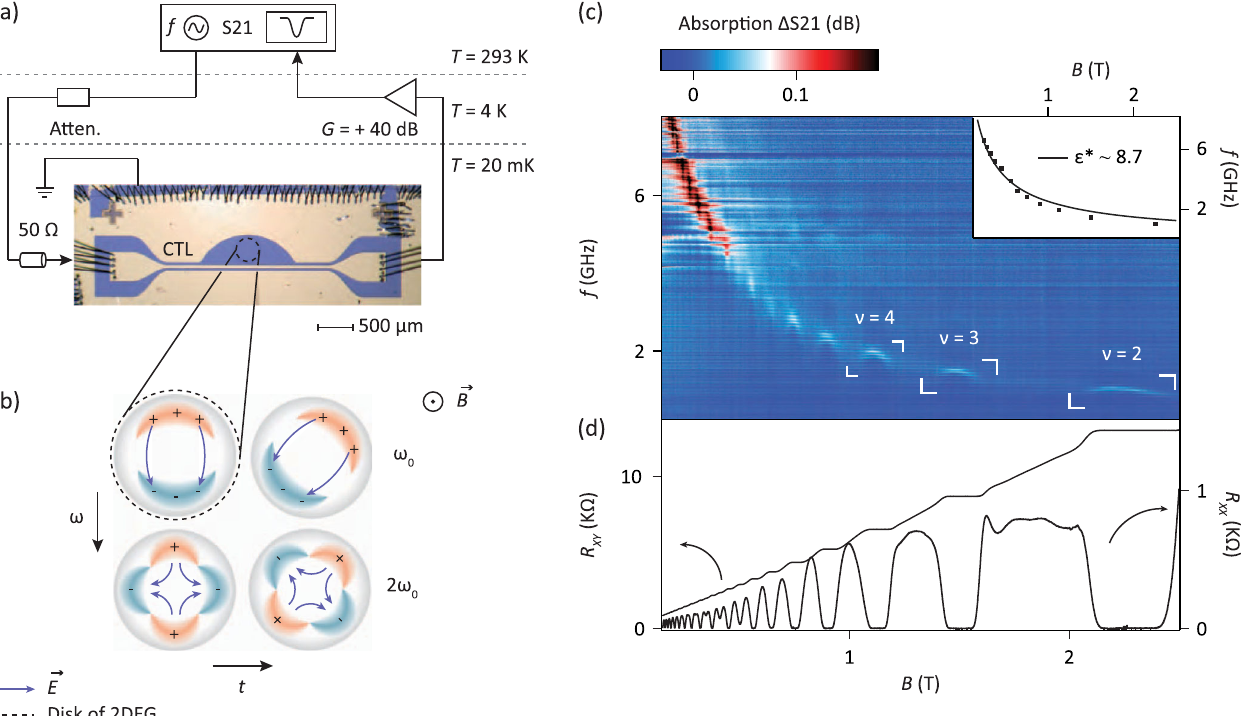
FIG. 1. Detecting microwave edge magnetoplasmons. (a) Experimental setup including photograph of a coplanar transmission-line device similar to that used to perform measurements coupled to a 350 - μ m etched disc of 2DEG (black dashed circle) at a fridge temperature of T ¼ 20 mK. A vector network analyzer is used to excite EMP modes across a wide frequency range, and microwave absorption is measured as the ratio of the amplified output to input signal ( S 21 ) from the CTL. (b) Illustration of the fundamental (top row) and first harmonic (bottom row) EMP modes as they evolve with time, where ω 0 is the fundamental mode and 2 ω 0 the first harmonic (adapted from Ref. [20]). Charge distributions and electric fields ~E are indicated schematically. An external magnetic field B applied to the device points out of the page. (c) EMP spectrum of the quantum Hall disk showing absorbed microwave power as a function of frequency and magnetic field. A background obtained at high field has been subtracted from the data. The inset shows the position of absorption dips at integer quantum Hall filling factors. The black line is a fit that allows an average effective dielectric constant of ϵ (cid:3) ≈ 8 . 7 to be extracted, consistent with excitations of an edge state in GaAs (see Ref. [28]). (d) Transverse ( R ) and xy longitudinal ( R ) Hall resistance measurements taken at T ¼ 20 mK on a Hall bar proximal to the microwave disk. The 2DEG is xx ¼ 1 . 1 × 10 11 cm − 2 and mobility μ ¼ 5 . 2 × 10 6 cm 2 = 270 nm below the surface with carrier density n s